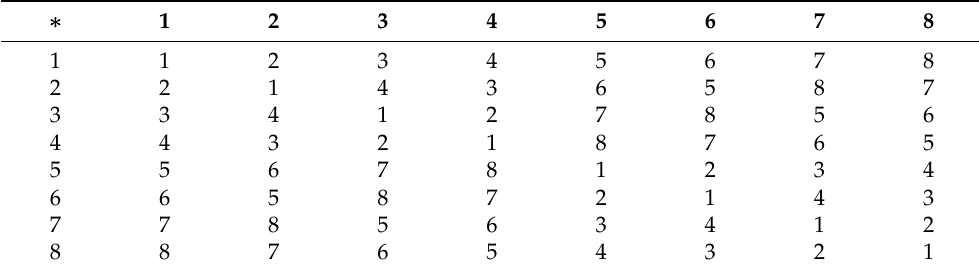
Table 8. A cancellative T2CA-groupoid of Example